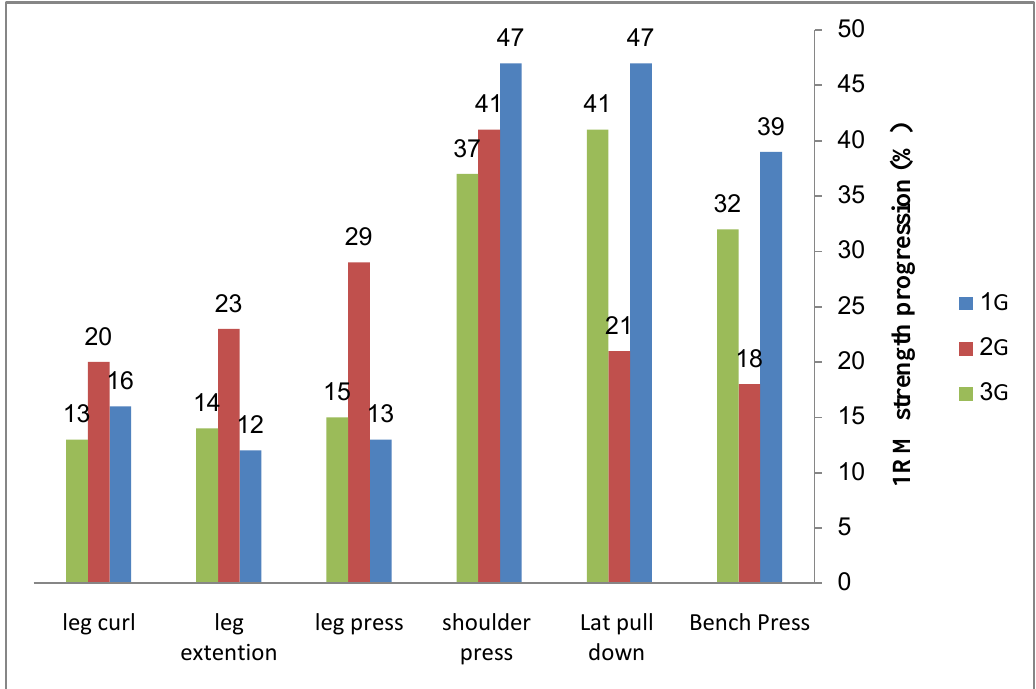
Fig. 1. 1RM strength progression (%) in each exercise of G1, G2 and G3 after 8 weeks of resistance training